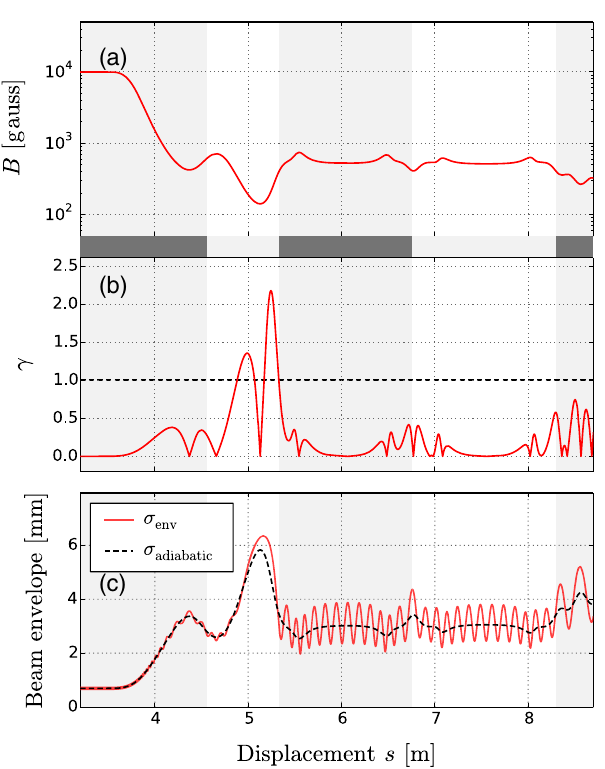
FIG. 5. Beam dynamics plots for a 50-eV ¯ p bunch extracted along beam path B, as shown in Fig. 1. (a) shows the on-axis magnetic field strength, while (b) shows the adiabaticity param- eter γ , and (c) shows two semianalytical solutions for the beam envelope. The horizontal axis has been shaded to match Fig.